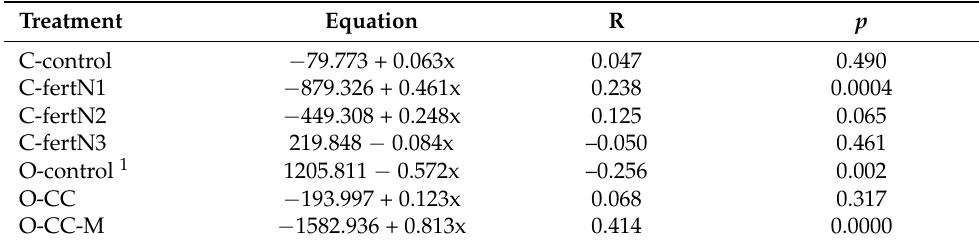
Table 5. Regression equations between SOC stock and year